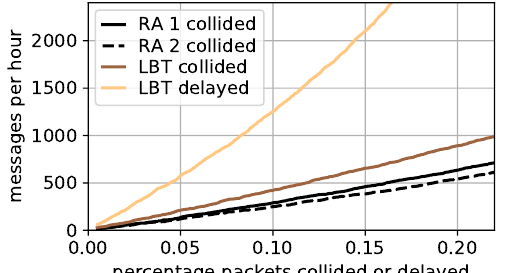
Figure A2. Collision probability comparison of random access (RA) and listen before talk